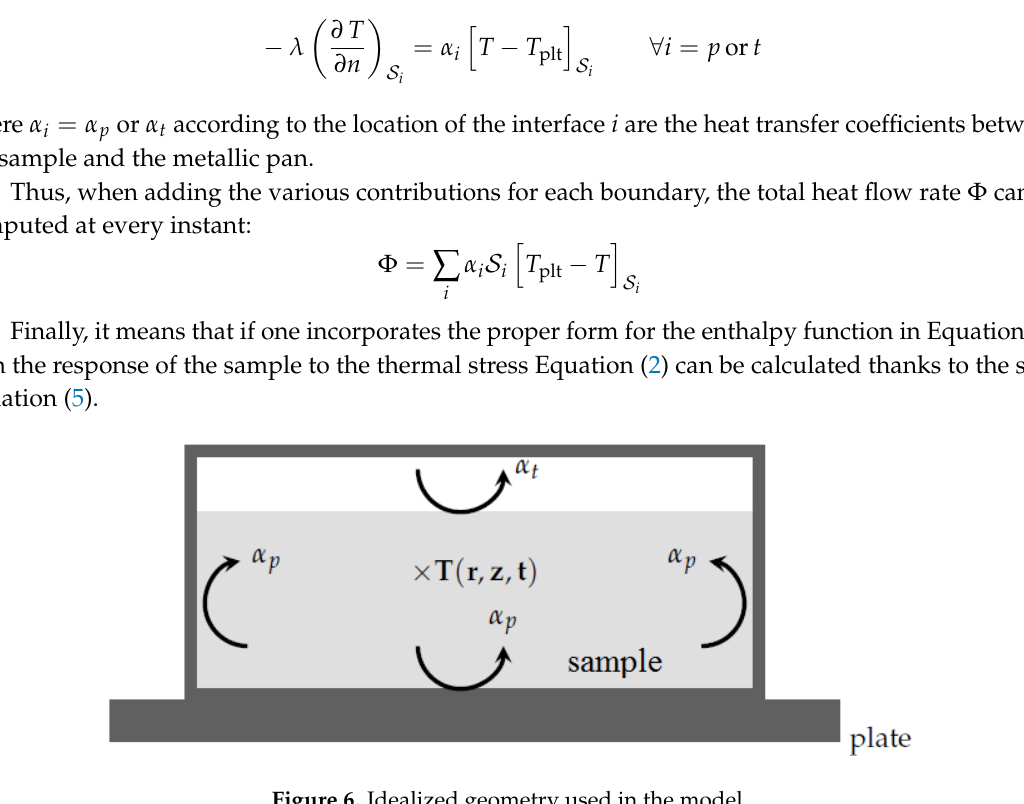
Figure 6. Idealized geometry used in the